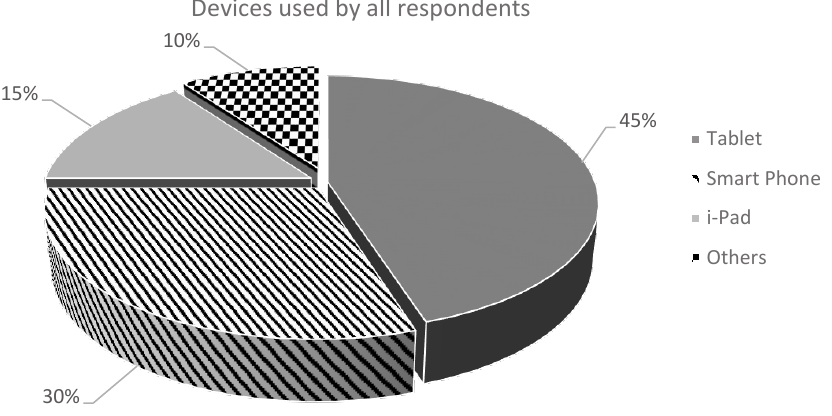
Figure 1. Devices used in Higher Learning Institutions